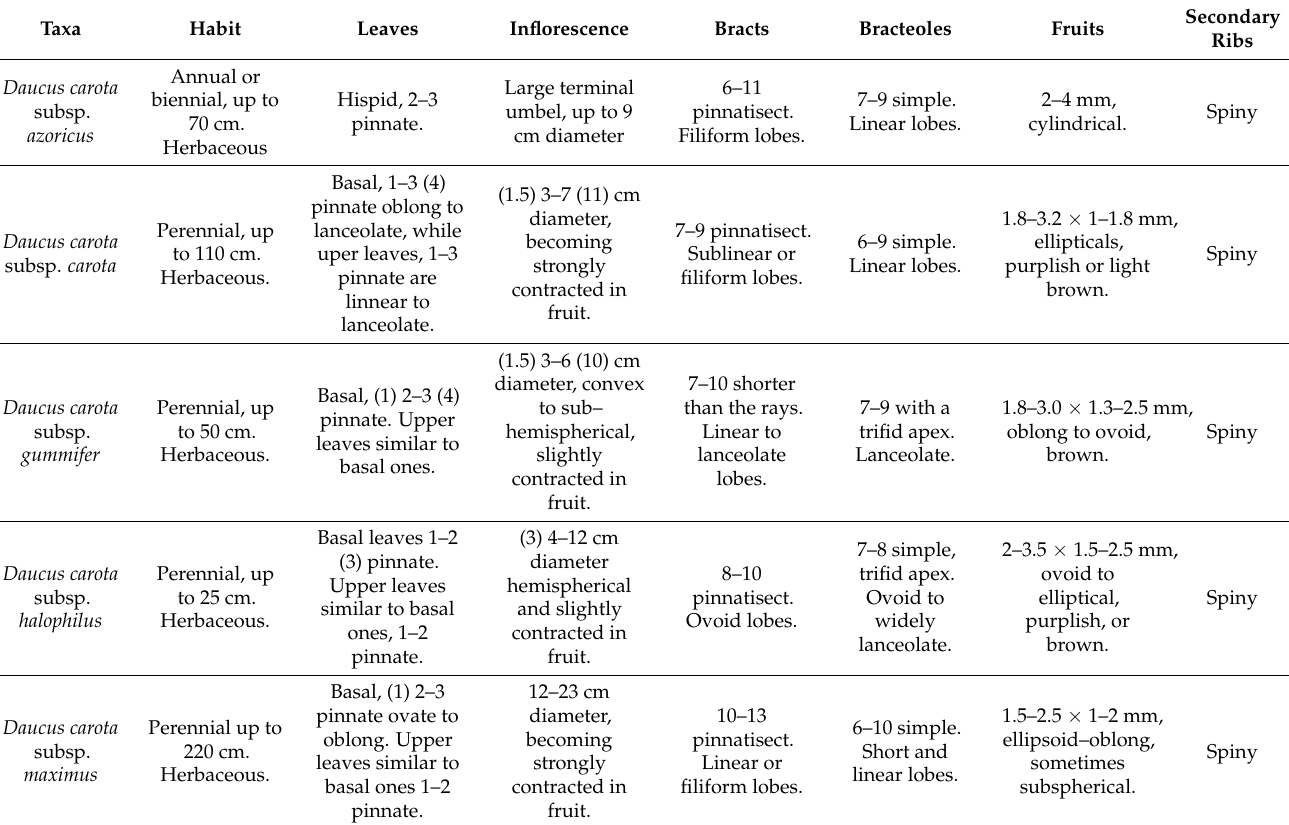
Table 2. Diagnostic characters of the sampled species of Daucinae subtribe, regarding habit, leaves, inflorescence, bracts, bracteoles, fruits, and secondary ribs in terms of bibliography (see references in the Material and Methods